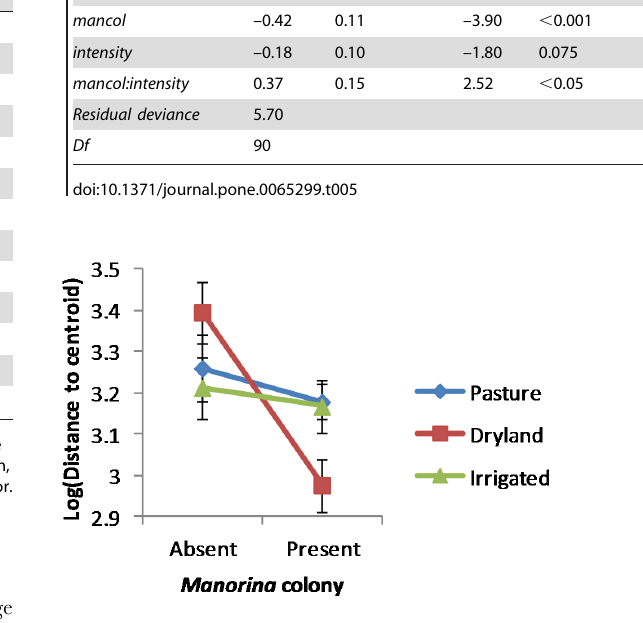
Figure 4. Plot of the mean log (Distance to centroid) ± standard error, displaying the interaction between the presence of Manorina colonies and the intensity of land use in the surrounding